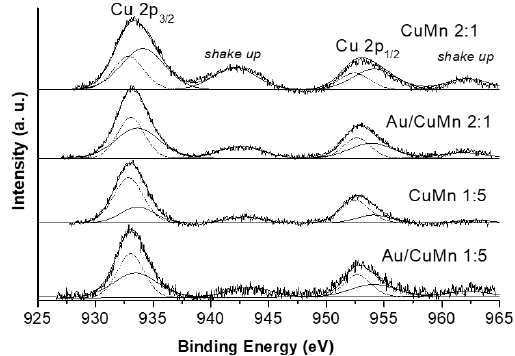
Figure 8. The Cu 2p XP spectra of alumina-supported CuMn mixed oxides and gold-containing catalysts.